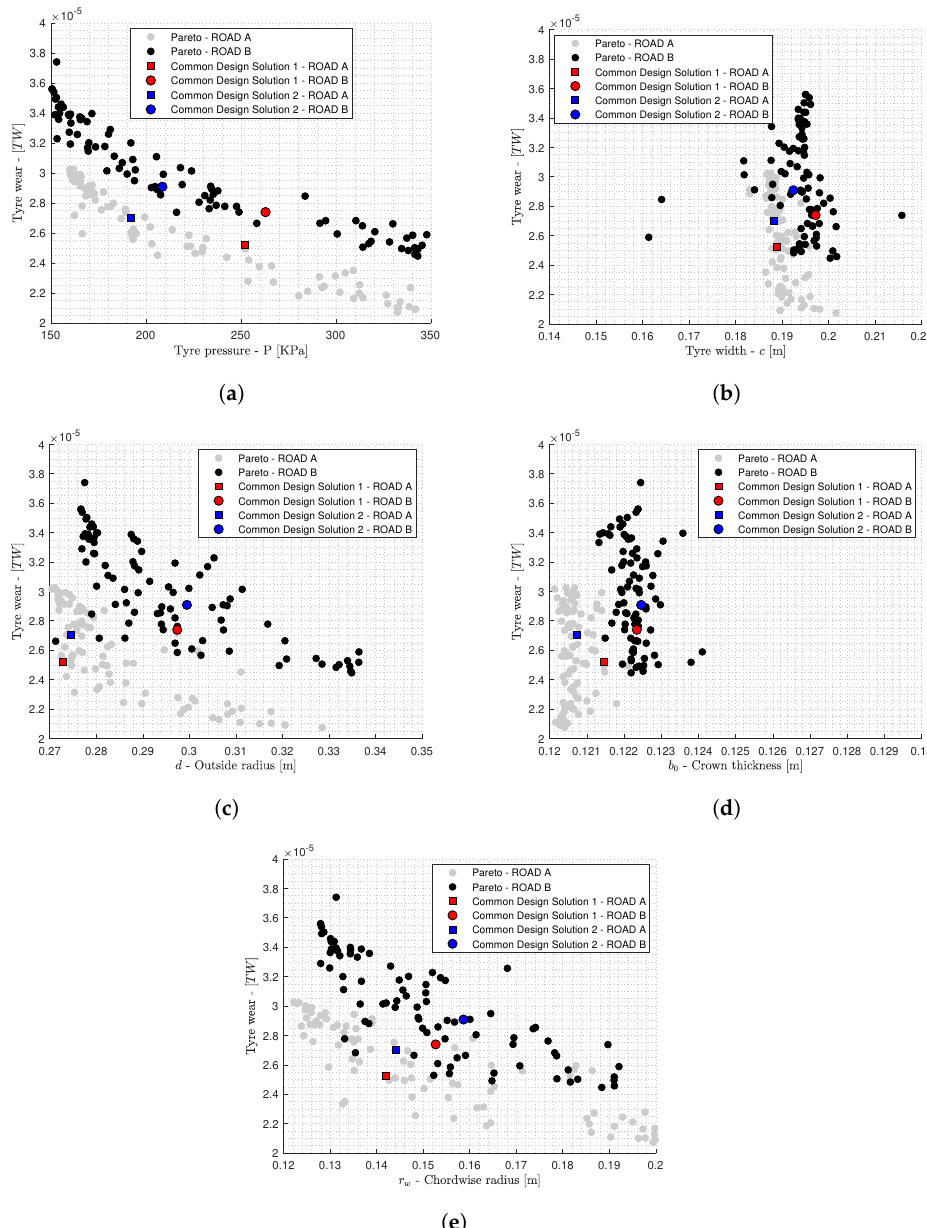
Figure 9. Comparison of the optimum solutions obtained for the two optimisation cases (Class A and B road profiles) in Scenario 1: ( a ) TW vs. P ; ( b ) TW vs. c ; ( c ) TW vs. d ; ( d ) TW vs. b 0 ; and ( e ) TW vs. r w